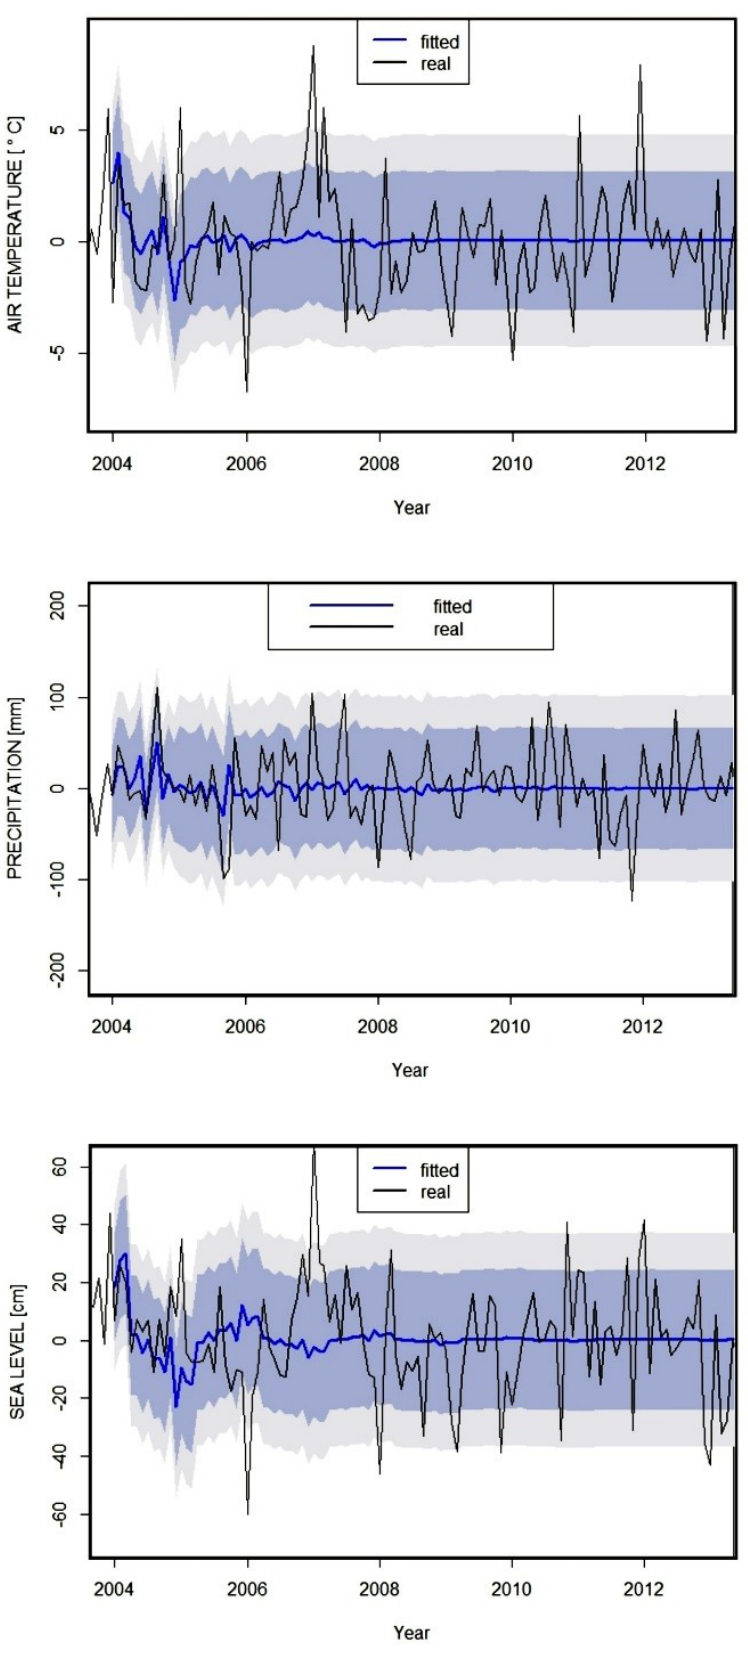
Figure 6. Out-of-sample accuracy analysis for hydrometeorological conditions in Ustka.